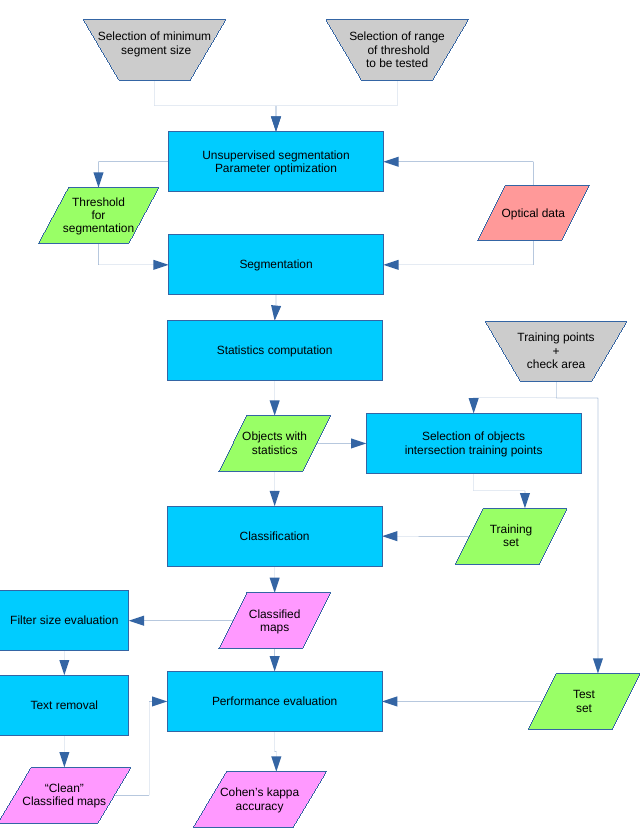
Figure 4. Flowchart of the classification and filtering